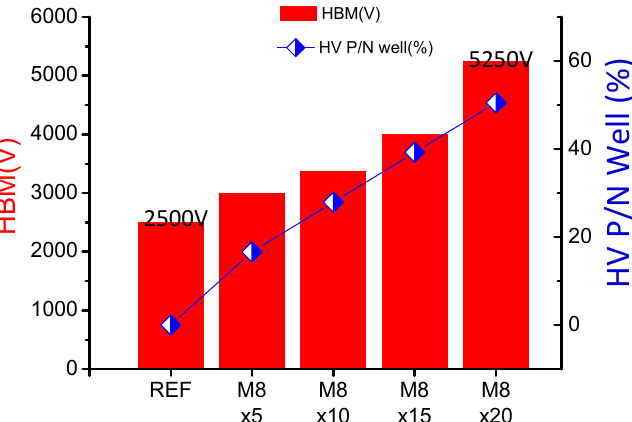
Figure 10. HBM values and SJ (HVPW) area % comparisons of UHV 300 V GGnLDMOSs type-M8 devices with di ff erent SJ length Xs.